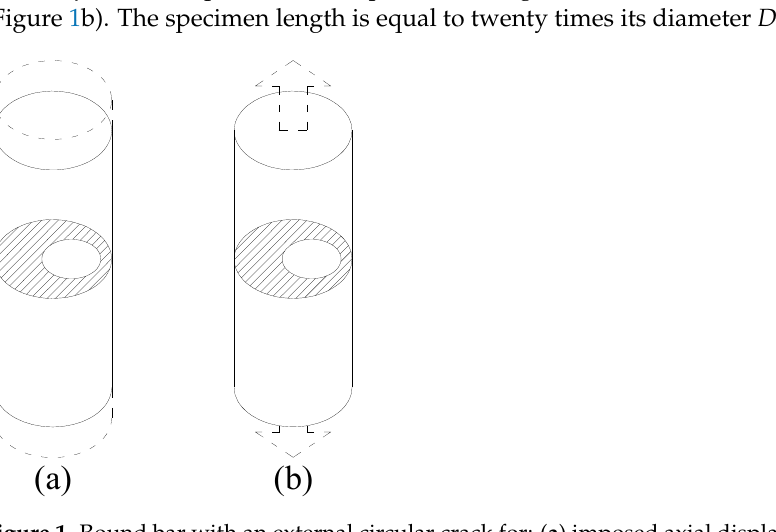
Figure 1. Round bar with an external circular crack for: ( a ) imposed axial displacement; ( b ) remote (axial) tensile loading.